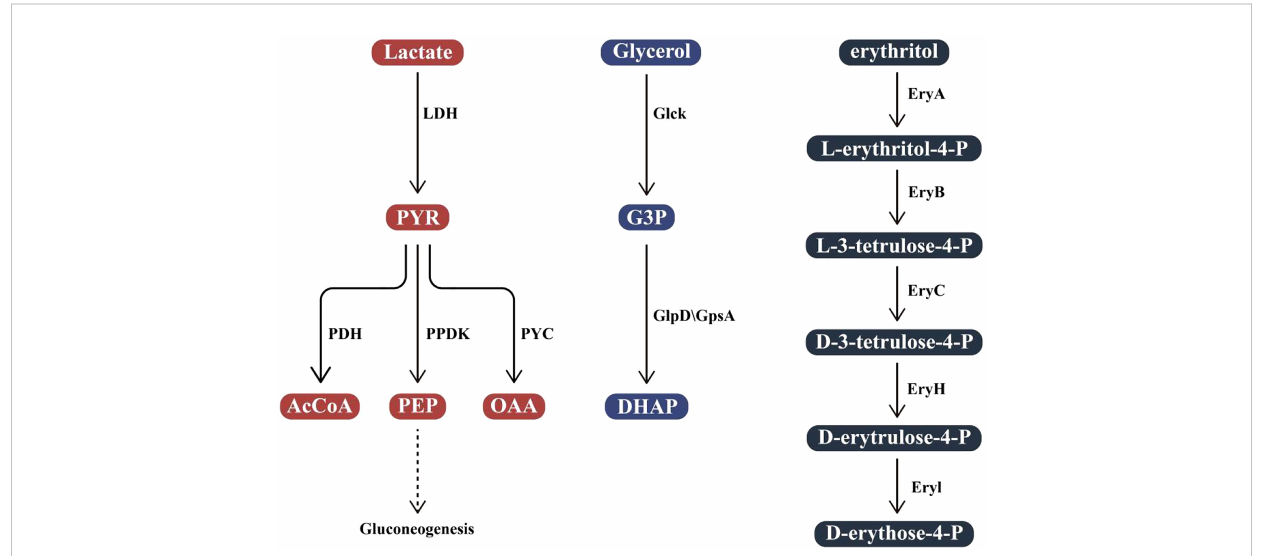
FIGURE 3 Utilization of polyols In Brucella. Lactate is converted into pyruvate (PYR) by L-lactate dehydrogenase (LDH). PYR is then phosphorylated by pyruvate phosphodikinase (PPDK) to produce phosphoenolpyruvate (PEP) and enter the gluconeogenesis pathway, converted to acetyl coenzyme A (AcCoA) by pyruvate dehydrogenase (PDH) or to oxaloacetate (OAA) by pyruvate carboxylase (PYC); Glycerol is converted to glyceraldehyde 3-phosphate (G3P) by glycerol kinase (GlcK). G3P is further activated by G3P dehydrogenase (GlpD) or G3P dehydrogenase (GpsA) to produce 3,4-dihydroxy acetophenone (DHAP). In B abortus, erythritol is fi rst phosphorylated by EryA to L-erythritol-4-P, then L-erythritol-4-P is oxidized by EryB to L-3- tetramethysaccharide-4-P and then transformed into D-erythrocyte 4-P, catalyzed by EryC, EryH, and EryI in